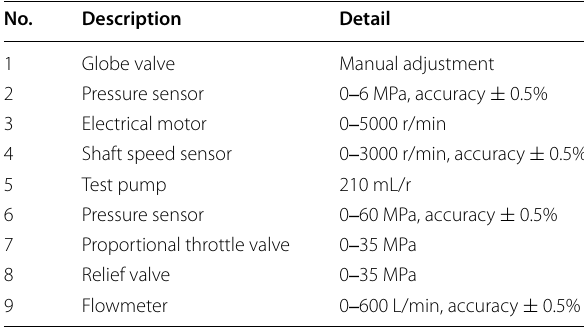
Table 2 Details of the hydraulic